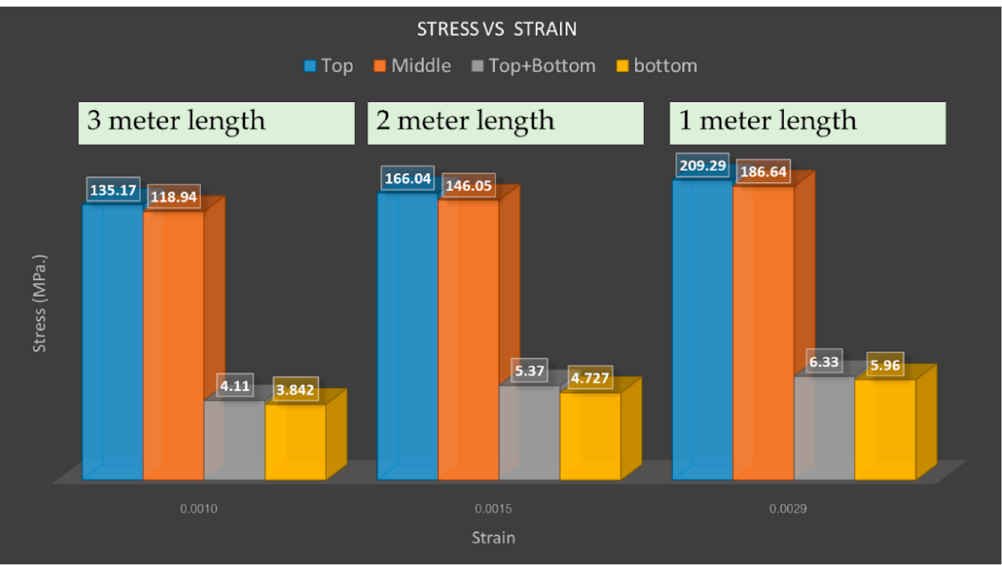
Figure 17. Stress vs strain.